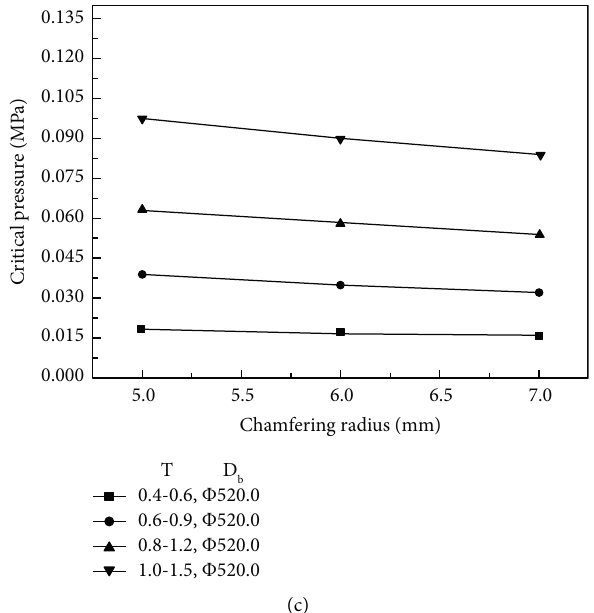
Figure 13: Efects of structural parameters on the critical pressure. (a) Tickness efects; (b) Bottom diameter efects; (c) Chamfering radius